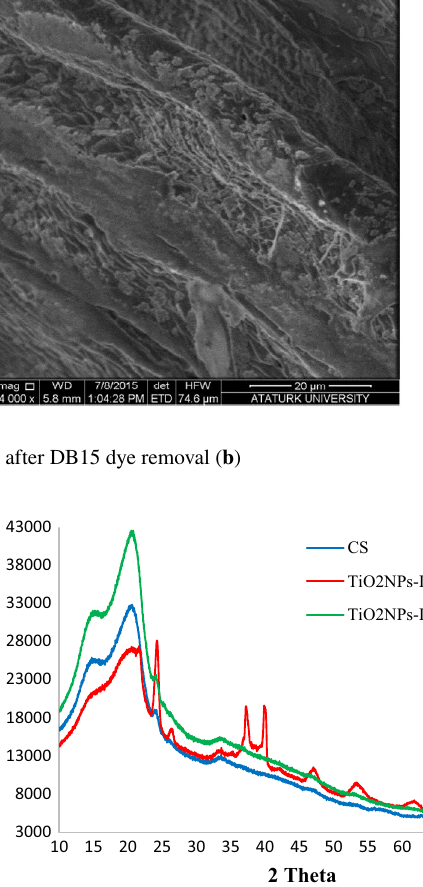
2 NPs, TiO 2 NPs-IML-CS and TiO 2